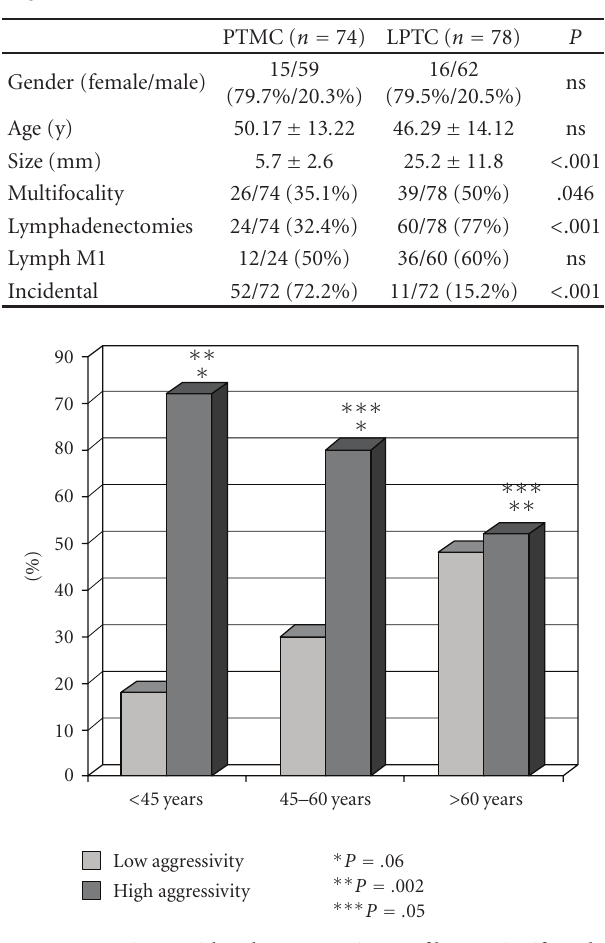
Figure 1: Patients with a low aggressive profile are significantly older than patients with a high aggressive